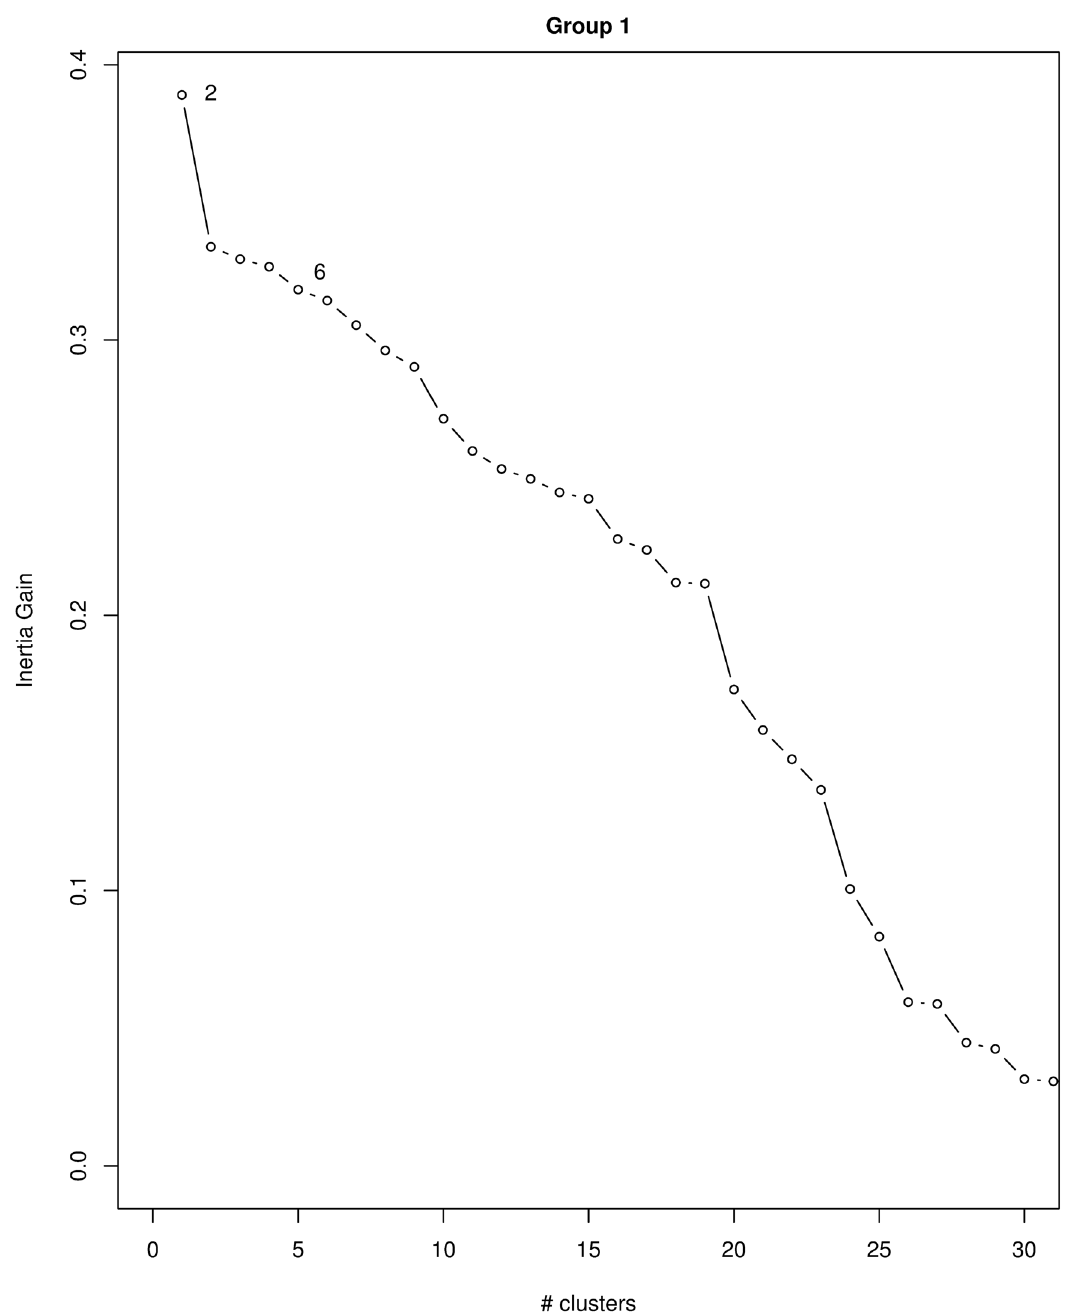
Fig 4. Plot of the between cluster inertia for group 1. Between cluster inertia (or inertia gain) smoothly decreases when the number of clusters increases. Sudden decreases of inertia occur at K = 2 (too small) and K = 10 (too large and difficult to interpret). We chose the intermediate value of K = 6 for data